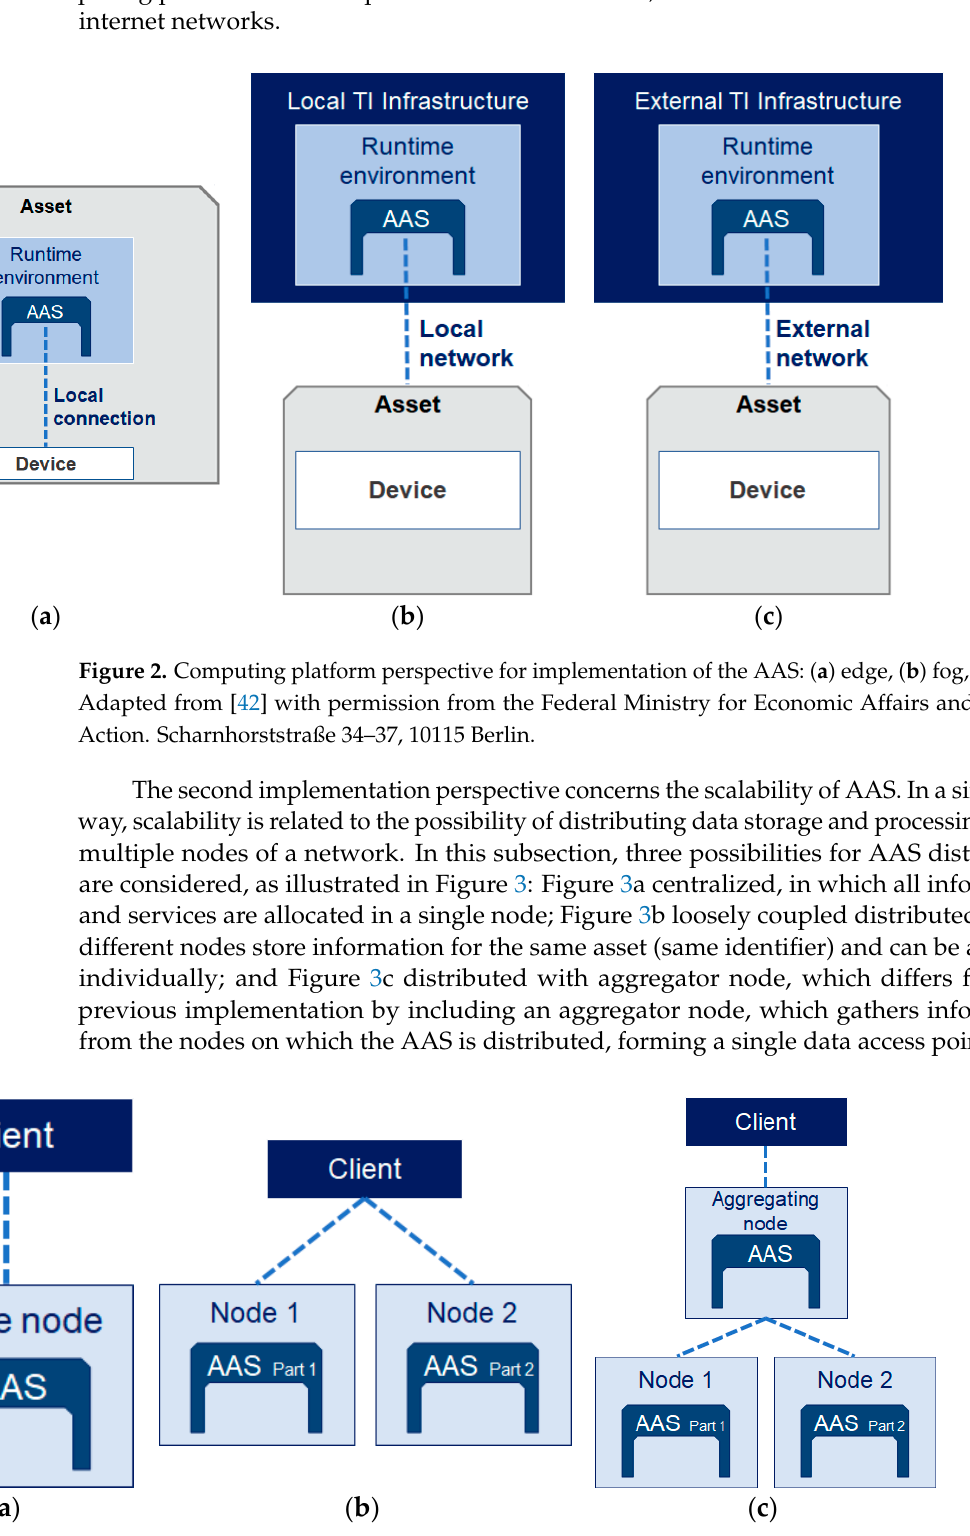
Figure 3. Distribution perspective for implementation of the AAS: ( a ) centralized, ( b ) distributed with loose-coupling, ( c ) distributed with aggregating node. Adapted from [42] with permission from the Federal Ministry for Economic Affairs and Climate Action. Scharnhorststraße 34–37, 10115 Berlin.